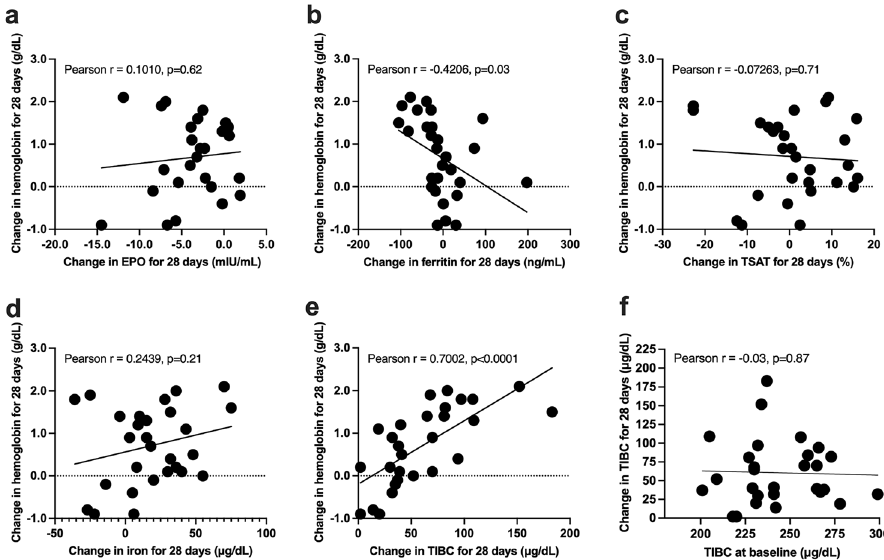
Figure 2. Associations among changes in hemoglobin and erythropoietin or parameters of iron metabolism, and between changes in total iron binding capacity and total iron binding capacity at day 0 during roxadustat treatment. Associations of changes in hemoglobin for 28 days with changes in erythropoietin ( a ), ferritin ( b ), transferrin saturation (TSAT) ( c ), iron ( d ), total iron binding capacity (TIBC) ( e ) for 28 days, and changes in TIBC for 28 days and TIBC at day 0 ( f ).